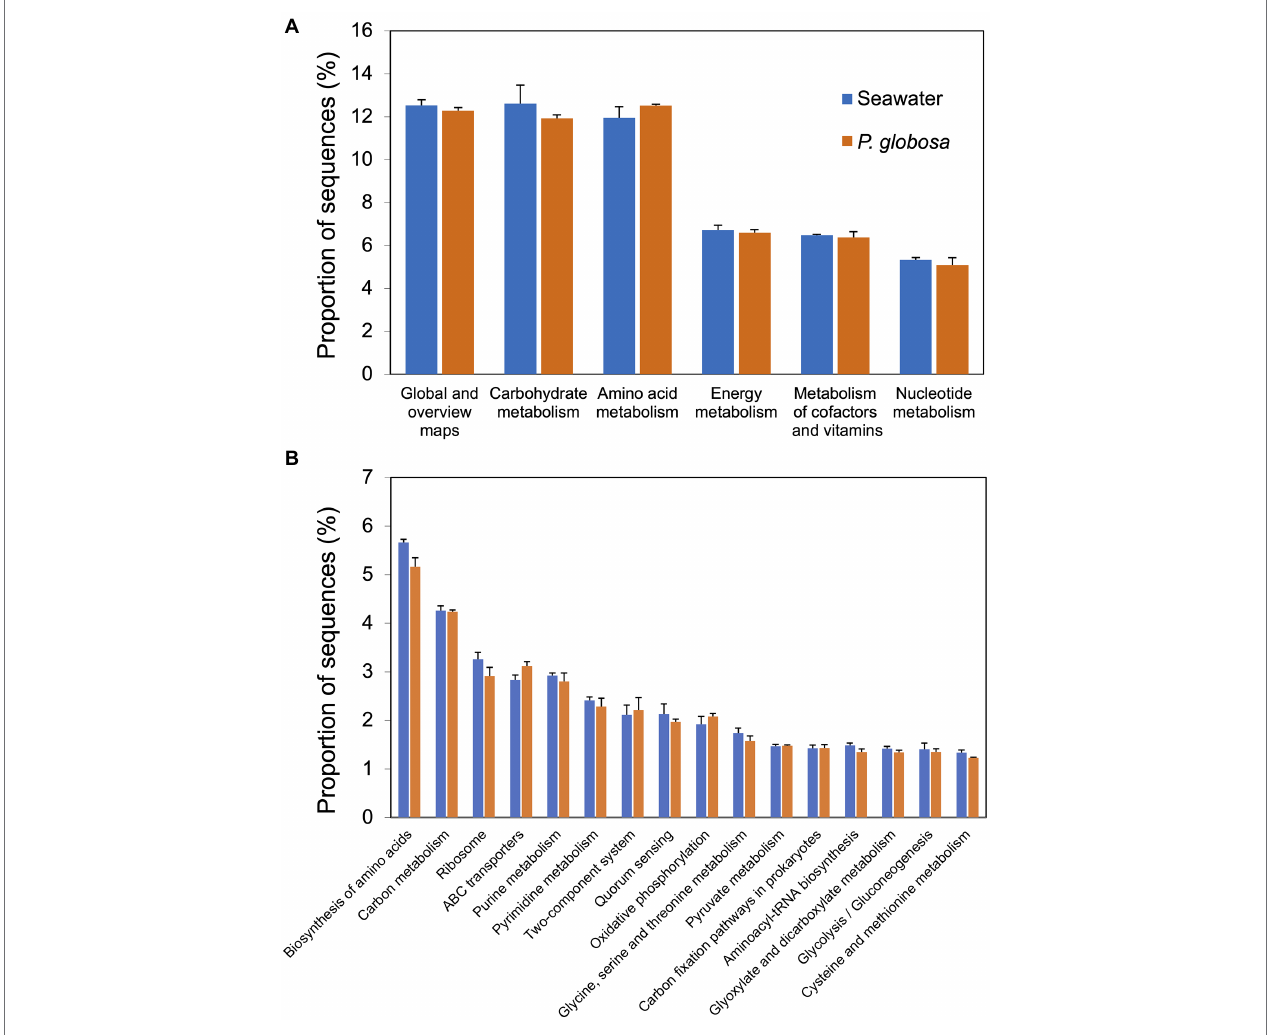
FIGURE 4 | Predicted microbial functions of samples collected from ambient seawater and P. globosa intracolonial fluid. Functions were categorized to KEGG pathway level 2 and level 3 using PICRUSt software. The top six dominant functions categorized to level 2 (A) and the top fifteen dominant functions categorized to level 3 (B) were ordered from largest contribution (left) to smallest contribution (right).